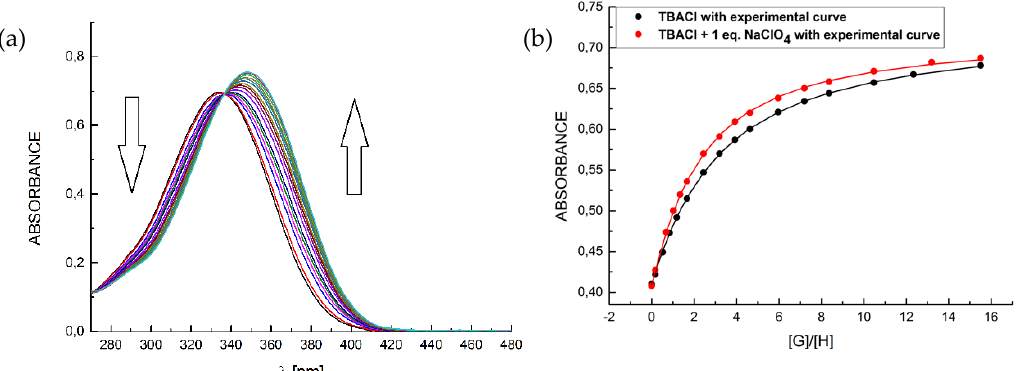
Figure 2. A representative binding behavior of receptor 2 upon gradual addition of TBACl: ( a ) UV-Vis titration spectra in the presence of 1 eq. of NaClO 4 and ( b ) corresponding experimental and theoretical binding isotherms for TBACl alone (black curve) and with the presence of 1 eq. NaClO 4 (red curve). Table 1. Association constants (log K a ) for the interactions between receptors 1 – 3 and selected anions in the absence or in the presence of one equivalent of NaClO 4 [a] .